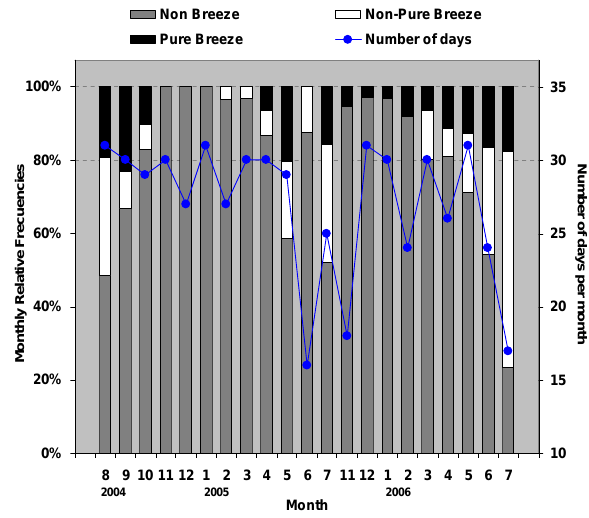
Fig. 7. Frequency of monthly occurrence as percentages of non- pure breeze and pure breeze and non-breeze days (left axis), and the number of days per month (right axis), during the two-year period under